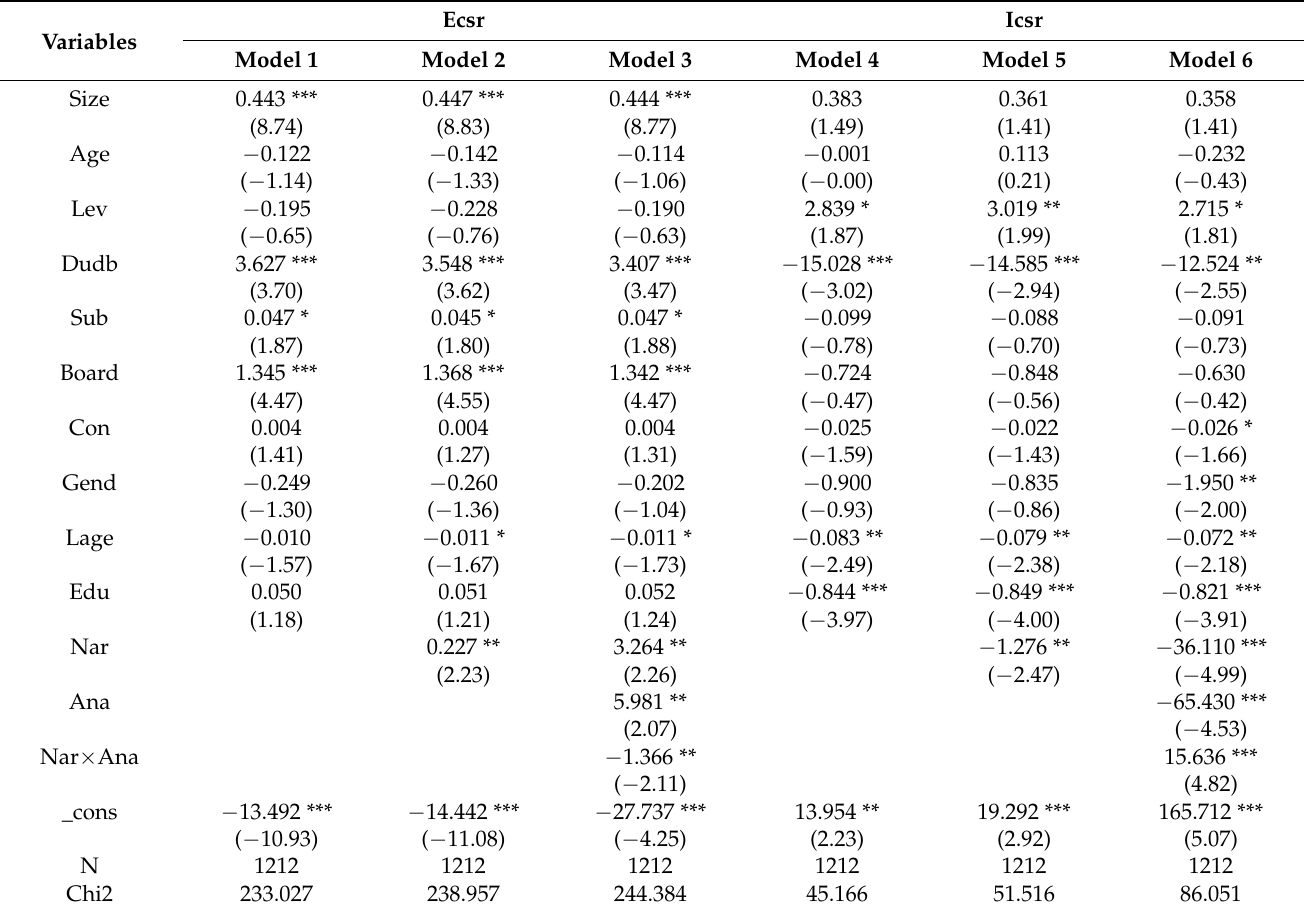
Table 4. Regression